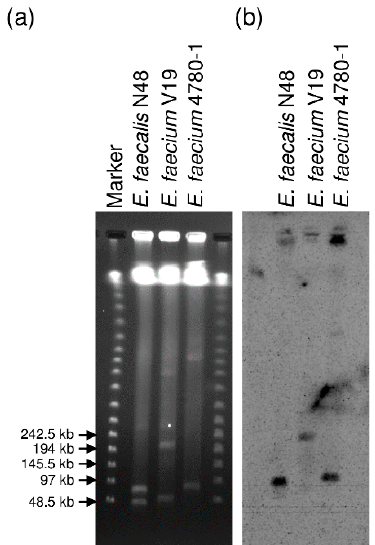
Figure 2. S1 nuclease PFGE analysis followed by Southern blot hybridization with the aadE probe of E. faecalis N48 , E. faecium V19, and E. faecium 4780-1: ( a ) S1 nuclease-digested DNAs separated by PFGE; ( b ) Southern blot hybridization of the aadE probe of the S1 nuclease-digested DNAs.